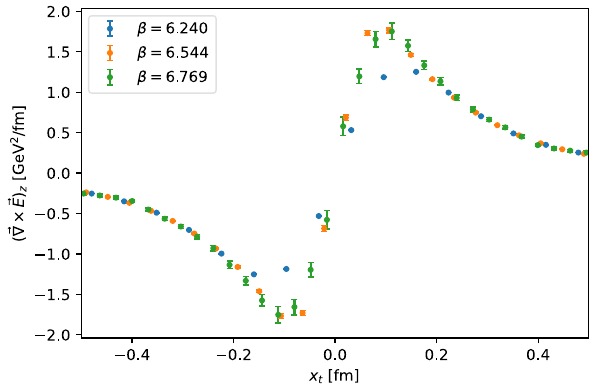
Fig. 5 Continuum scaling for the magnetic current ( ∇ × E ) z extracted at the (position dependent) optimal value of smearing at a transverse plane x l = d / 4 ≈ 0 . 128